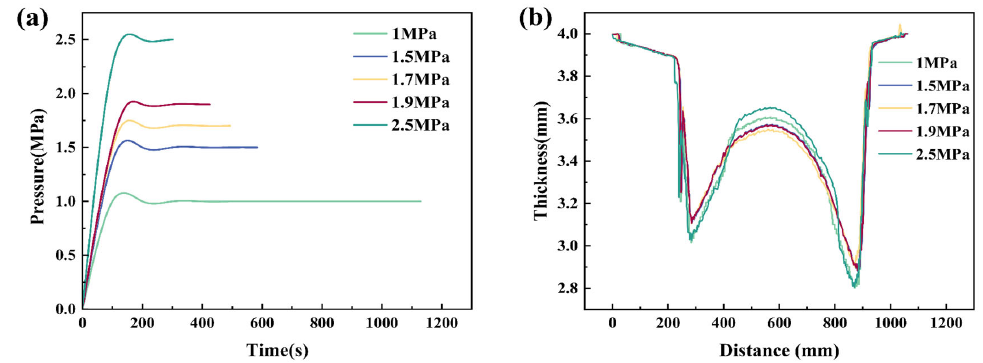
Figure 9. ( a ) Pressure curves, ( b ) Thickness distribution on the connection between the center of the sharp fillet.